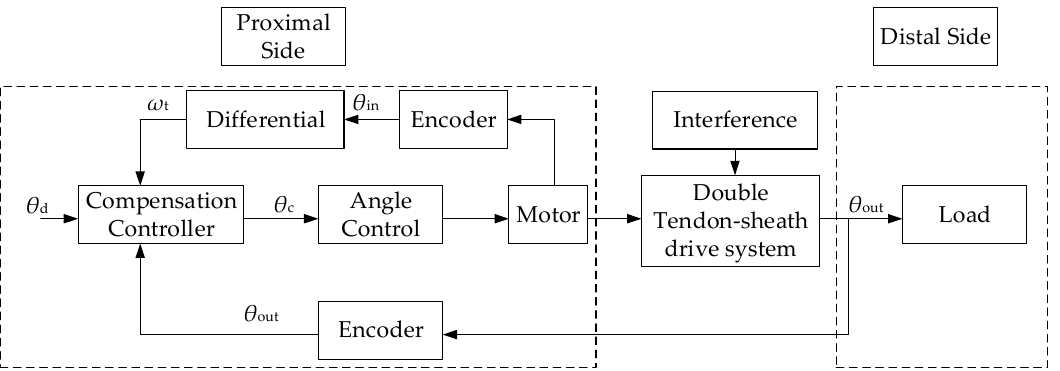
Figure 10. Compensation control model of a double tendon sheath transmission system.